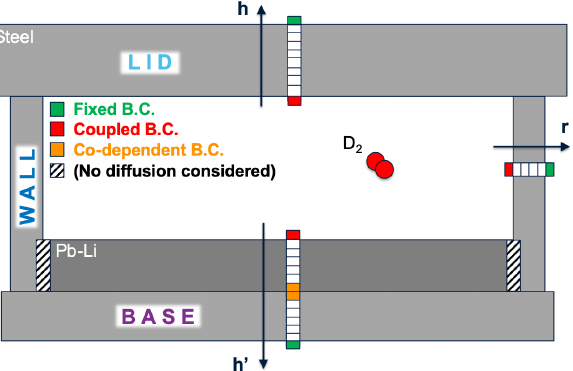
Figure 10. Schematic of the VST’s Upper Chamber as modelled using the quasi-2D modelling approach for simulations that include Pb-Li. No radial diffusion is assumed for the WALL surface covered by Pb-Li. The lower vertical diffusion channel is extended to double metallic barrier channel, with a set of Co-Dependent BCs at the metal-metal interface (in orange ).